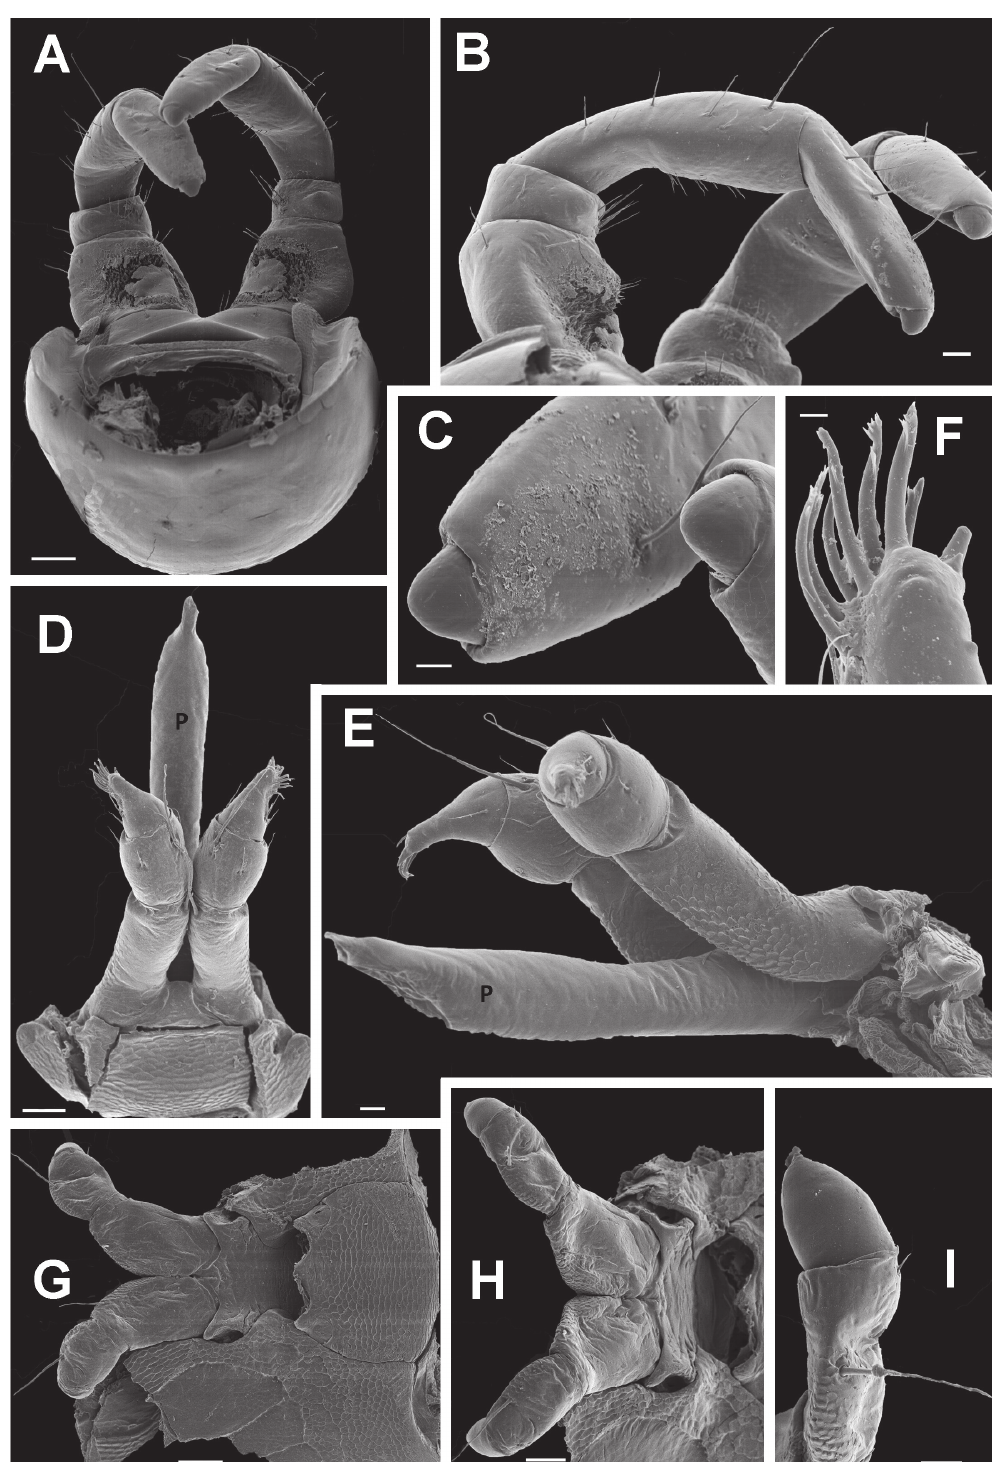
Fig. 5. Koiulus interruptus gen. et sp. nov., paratype, ♂, from the upper course of the river Ko. A–C . First pair of legs. A . Anterior view. B . Sublateral view. C . Tips. – D–F . Second pair of legs, and penis. D . Anterior view. E . Lateral view. F . Modified setae on tip of leg. – G–I . Seventh pair of legs. G . Ventral view. H . Posterior-ventral view. I . Tip of one telopodite. P = penis. Scale bars: A, G = 0.1 mm; B, D, H = 0.05 mm; C, E, I = 0.02 mm; F = 0.005